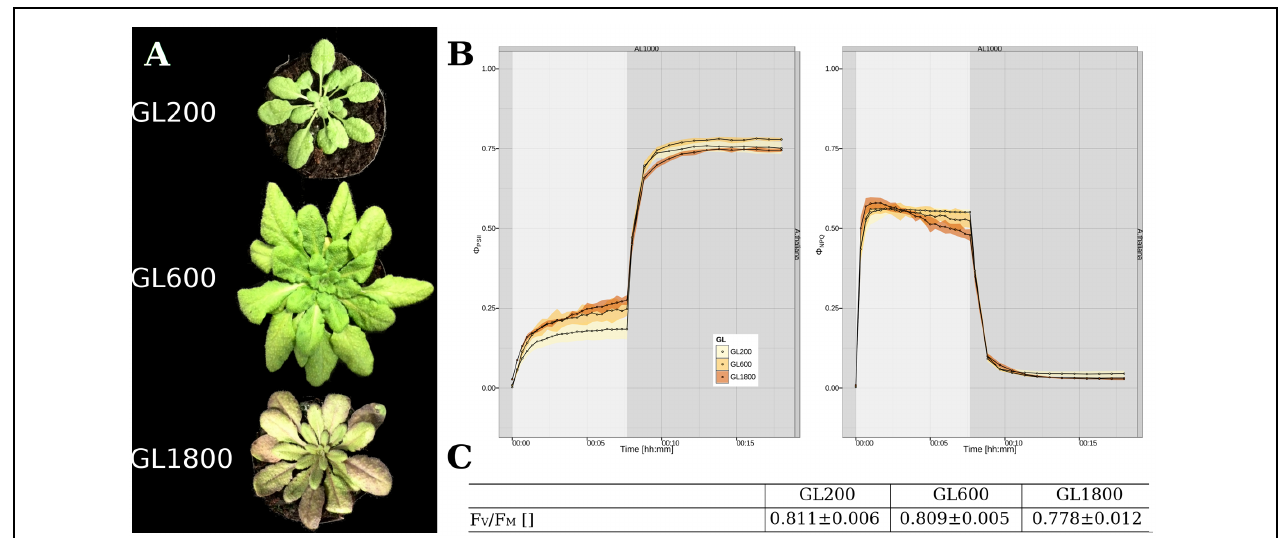
FIGURE 1 | General characterization of plants long-term acclimated to different light intensities. (A) Visual appearance of the Arabidopsis thaliana plants grown under 200 (GL200), 600 (GL600), and 1800 μ mol photons ∗ m − 2 ∗ s − 1 (GL1800). (B) Parameters from the quenching analysis related with the energy distribution in PSII, (cid:2) PSII (Left panel) and (cid:2) NPQ (Right panel) during an 8 min illumination with 1000 μ mol photons ∗ m − 2 ∗ s − 1 and 10 min of darkness for plants grown under 200, 600, and 1800 μ mol photons ∗ m − 2 ∗ s − 1 , respectively, as a yellow, orange and brown trace, ( n = 4). The illumination and dark periods are marked, respectively, as gray and white background. (C) Dark fluorescence parameter F V / F M of plants grown at all three light intensities ( n = 4).